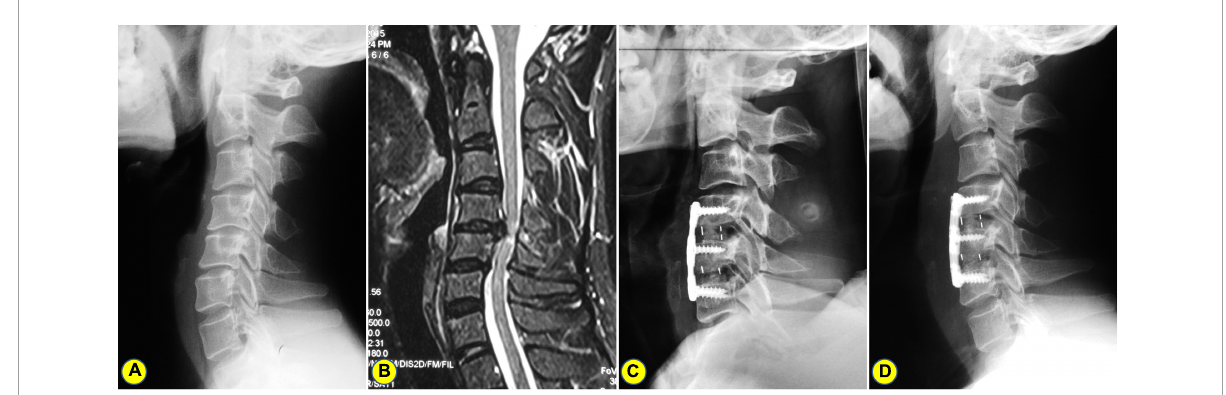
FIGURE3 A 57-years-old man who underwent anterior cervical discectomy and fusion (ACDF). (A) The preoperative lateral X-ray shows the C2-7 Cobb angle and curvature index (CI) are 15 ◦ and 9.49%, respectively. (B) Preoperative magnetic resonance imaging (MRI) showing C4-6 spinal cord compression combined with kyphosis. (C) A postoperative lateral X-ray showing ACDF. (D) On the lateral X-ray of 2.5 years after surgery, the C2-7 Cobb angle and CI were 7 ◦ and 16.09%, respectively.